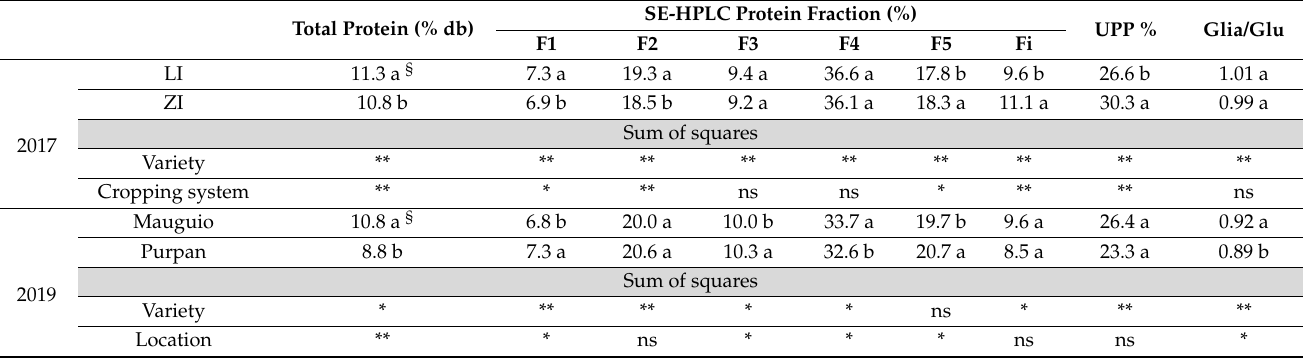
Table 6. Means of the protein quality parameters measured on ground grains (lab-milled grains) grown under zero-input conditions (ZI) and low input conditions (LI) in Mauguio in 2017, and Sum of squares (SS Effect/SS Model) for the variety and location effects. Mean of protein quality criteria measured on ground grains harvested in 2019 in 2 locations (Mauguio and Purpan), and Sum of squares (SS Effect/SS Model) for the variety effect and location effect. SE-HPLC Protein Fraction (%) Total Protein (% db) UPP % Glia/Glu F1 F2 F3 F4